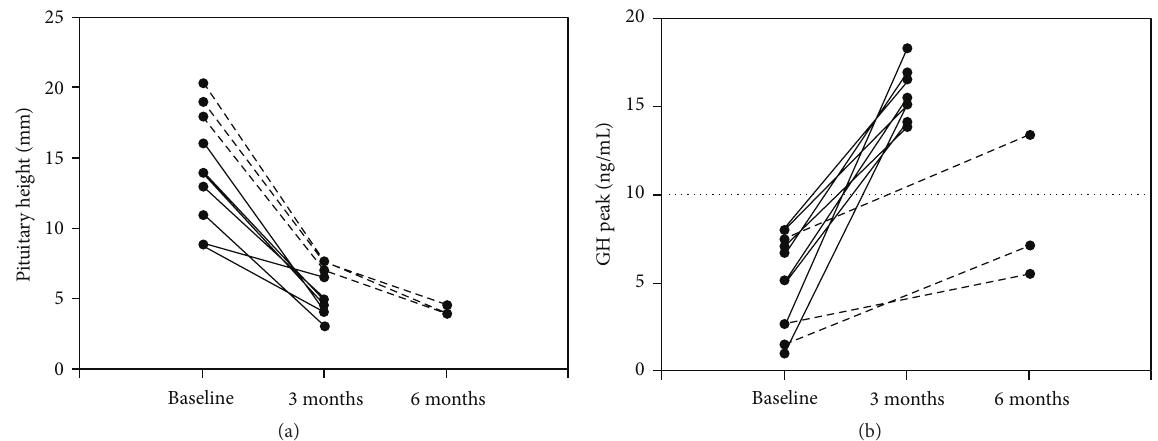
Figure 1: Changes in pituitary hyperplasia and low GH levels in short-stature children with PPH before and after L-T 4 therapy. In eight children (solid lines), pituitary hyperplasia and low GH levels returned to normal after 3 months of L-T 4 therapy. In three children (patients 4, 5, and 6) (dotted lines), pituitary hyperplasia returned to normal after 6 months of L-T 4 therapy. GH levels returned to normal in patient 4 and were still low in patients 5 and